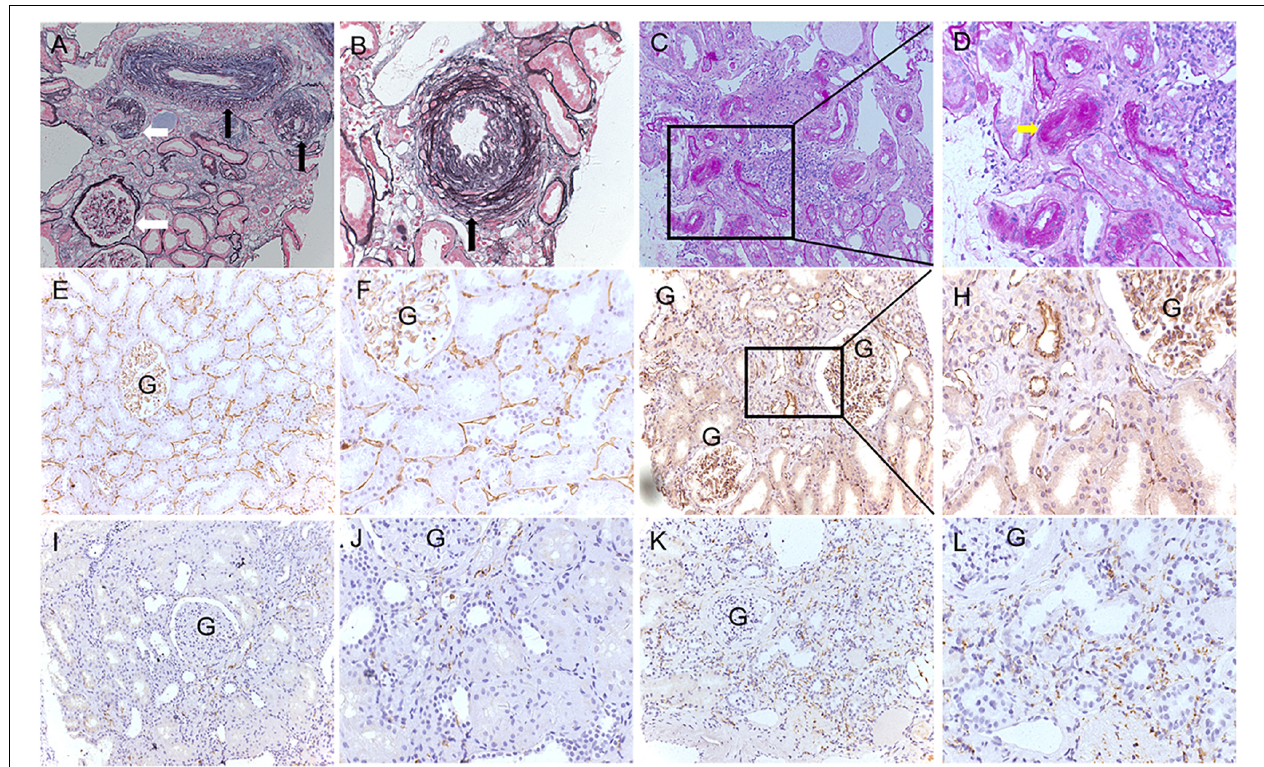
FIGURE 2 | Representative pathological features of arterionephrosclerosis. (A,B) Show arteriosclerosis with narrowing of the lumen (black arrows) and ischemic glomerular changes (white arrows) by PASM staining ( A , 200 × ; B , 400 × ). (C,D) Showed arteriolar hyalinosis with narrowing of the lumen (yellow arrow) by PAS staining ( C , 200 × ; D , 400 × ). (E–H) Show peritubular capillaries by immunohistochemical staining of CD34 in normal controls ( E , 200 × ; F , 400 × ) and arterionephrosclerosis ( G , 200 × ; H , 400 × ). (I–L) Show infiltration of macrophages by immunohistochemical staining of CD68 in the normal control ( I , 200 × ; J , 400 × ) and arterionephrosclerosis ( K , 200 × ; L , 400 ×